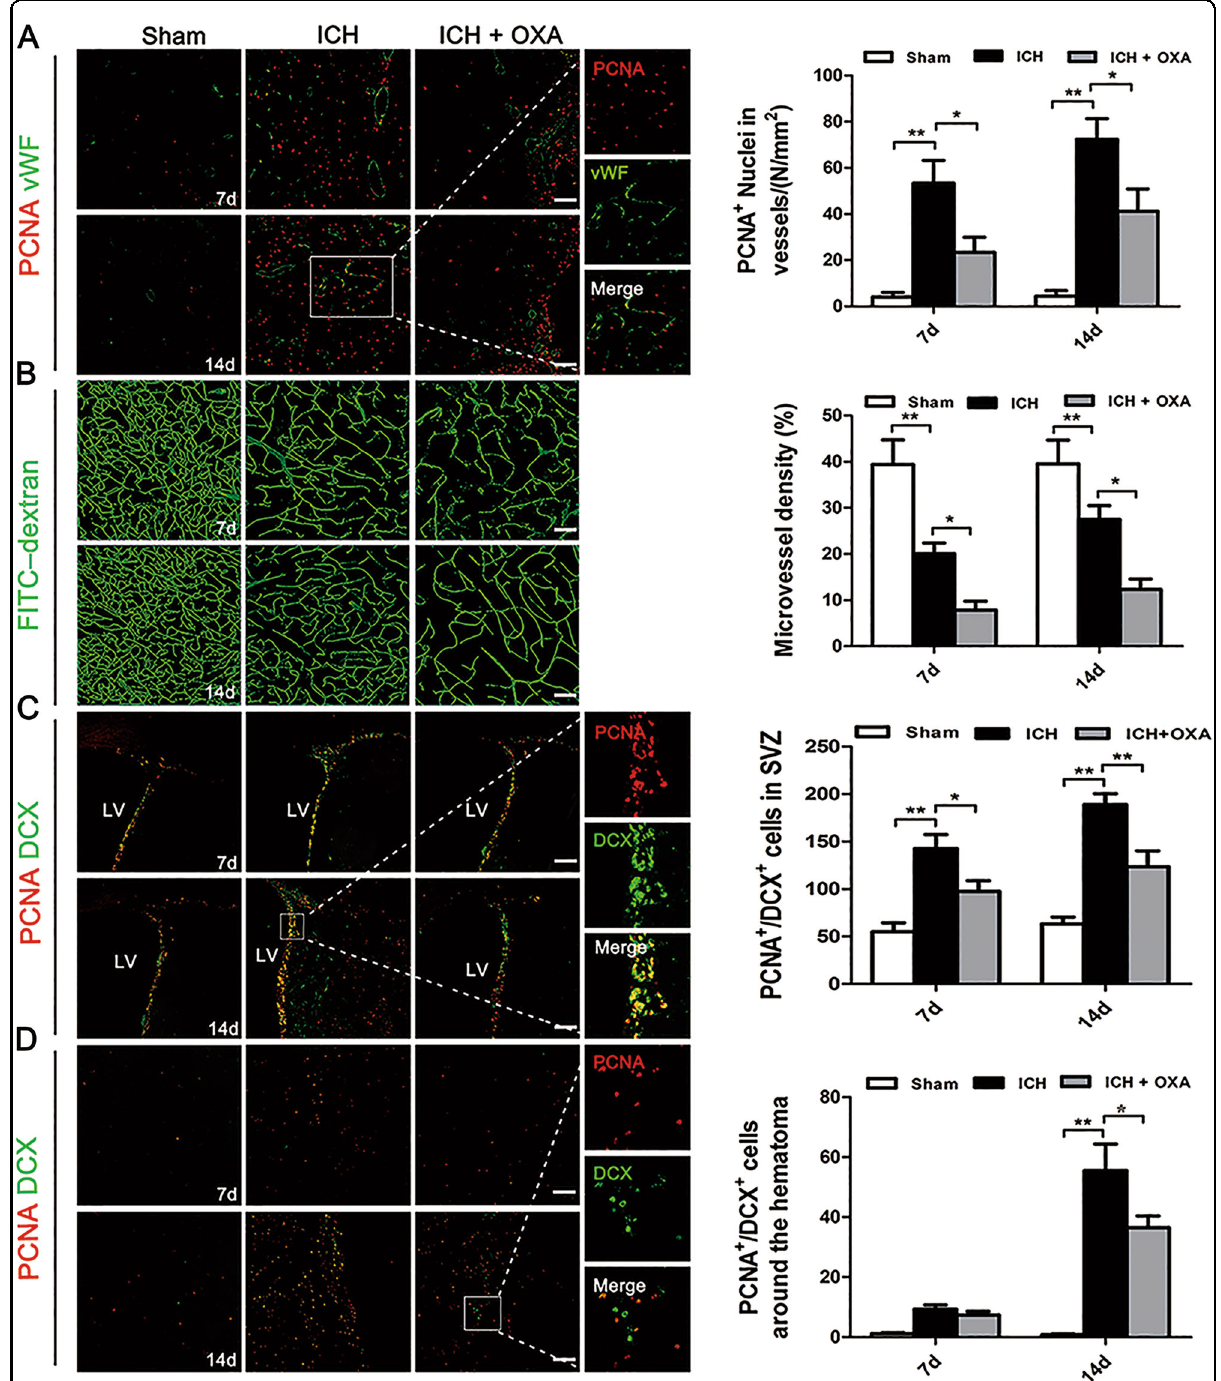
Fig. 2 a Newborn nuclei in vWF + vessels were present around the hematoma after ICH; OXA dramatically reduced PCNA + nuclei in ECs. b In the ICH group, the brain vasculature was deformed and blood fl ow was obstructed. OXA further diminished the vascular density after ICH. c , d PCNA + /DCX + cells were more prevalent after ICH than in the Sham group. OXA infusion notably decreased the numbers of PCNA + /DCX + cells after ICH. ICH intracerebral hemorrhage; OXA oxamate. * p < 0.05 and ** p < 0.01. n = 5. Scale bar = 100 μ